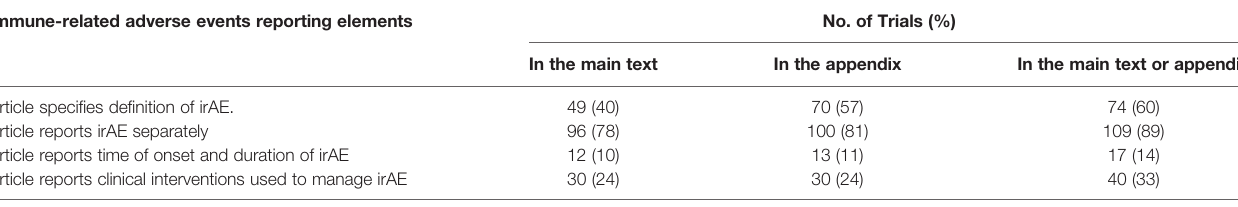
TABLE 4 | Presentation of immune-related adverse events.